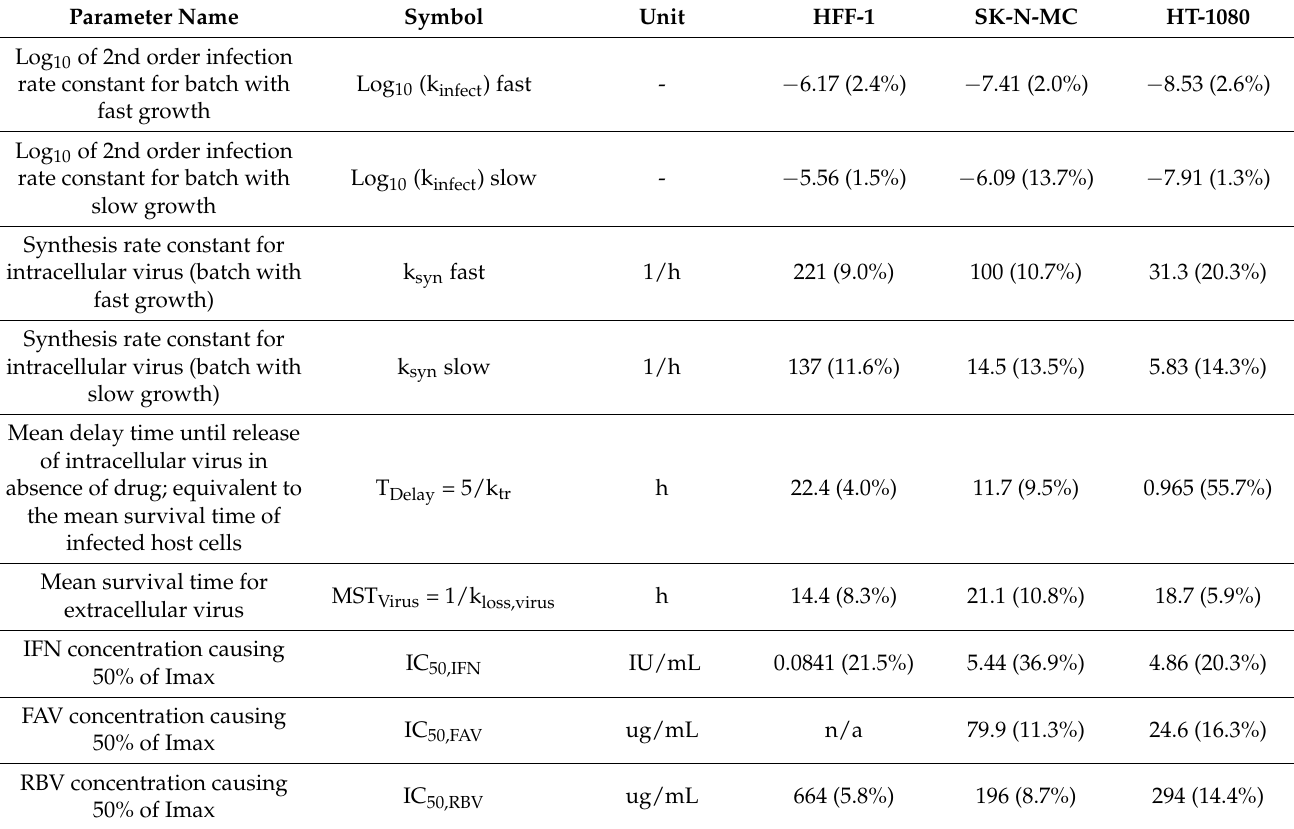
Figure 4. Predicted vs. observed fits for CHIKV viral burden in HT-1080, SK-N-MC, and HFF-1 cells. The green line represents the line of identity and the dashed blue line is a LOESS (locally weighted smoothing) smoother of the observations. Curve fits were unbiased, since the blue line fell on top of the green line. Table 1. Population mean parameter estimates for the pharmacokinetic/pharmacodynamic (PK/PD) model of FAV, RBV and IFN antiviral activity against